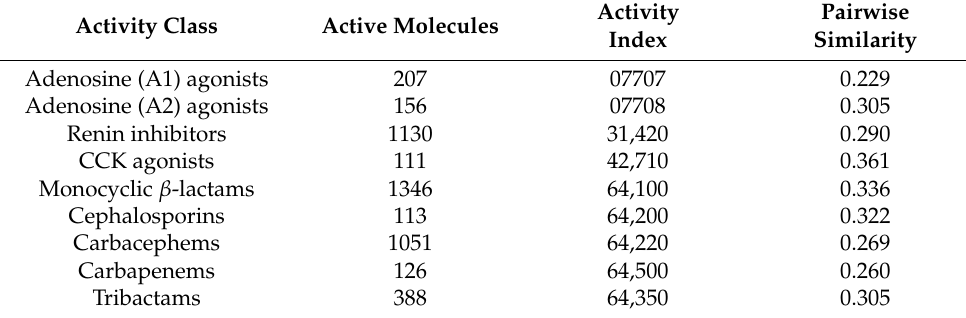
Table 2. The MDDR-DS2 structure activity